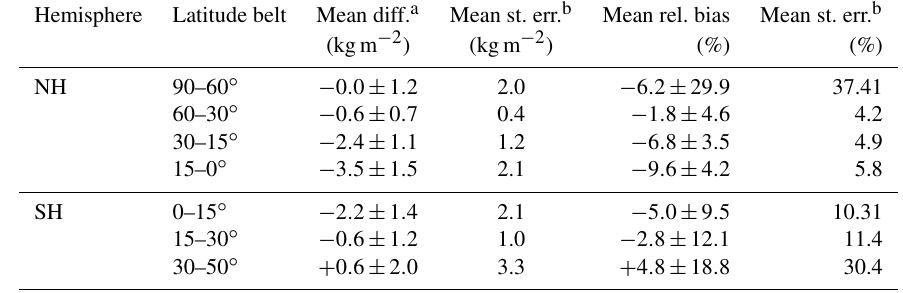
Table 2. The zonal statistics of the co-located satellite- and ground-based observations. Hemisphere Latitude belt